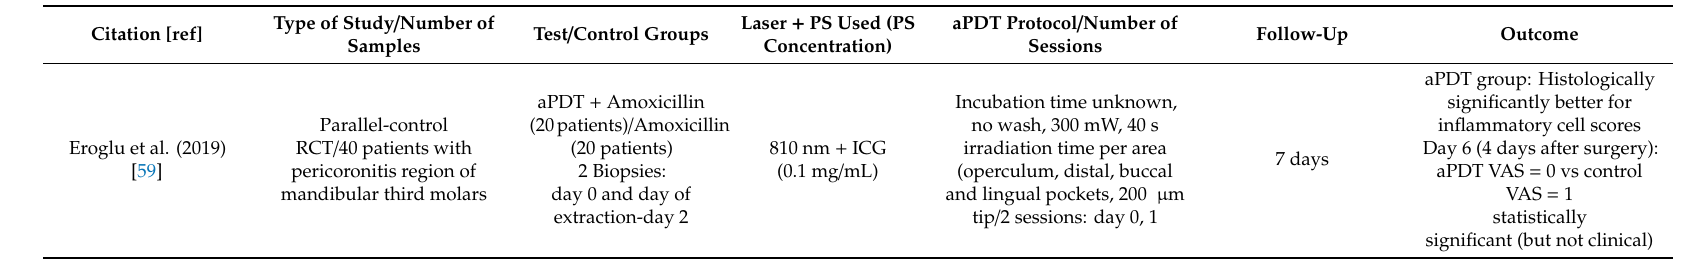
Table 7. Study of aPDT in healing